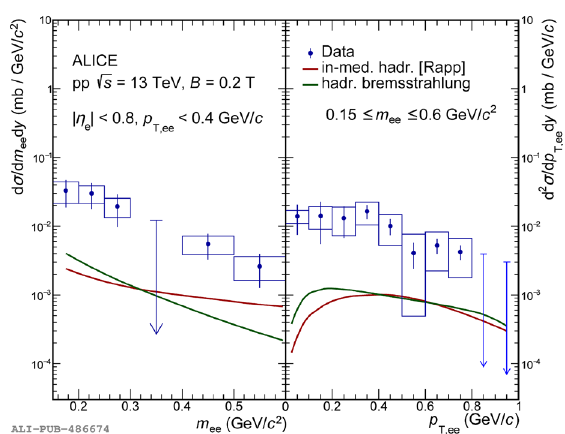
Figure 4. Dielectron excess spectra as a function of m ee (left) and p T , ee (right) compared to calcula- tions of bremsstrahlung from initial- and final-state hadrons, and thermal dielectron production in pp collisions at √ s = 13